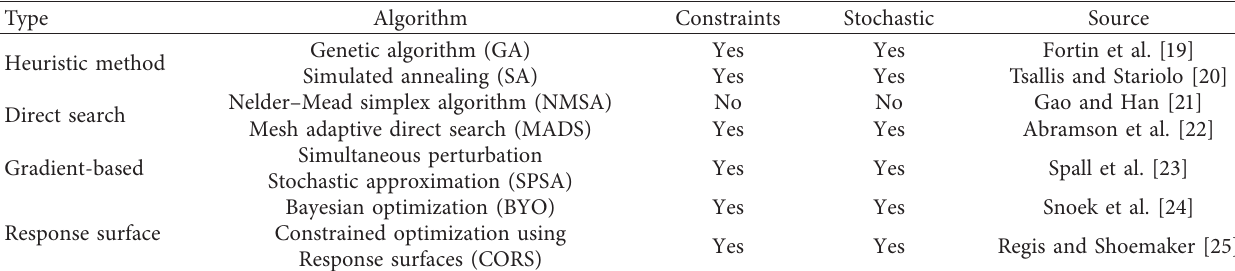
Table 1: Algorithms’